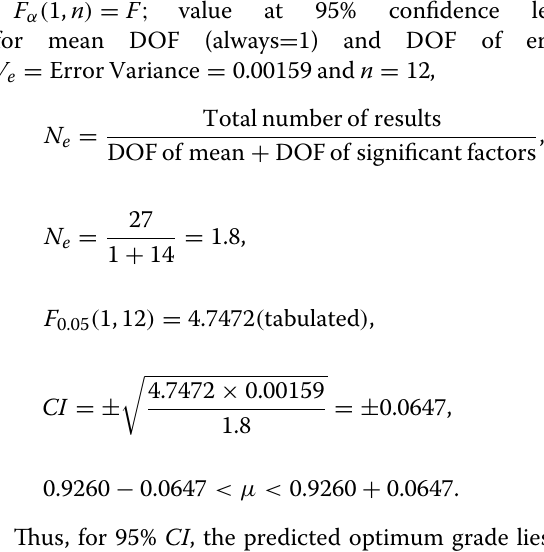
Figure 10 3D printed surgical tools (forceps and